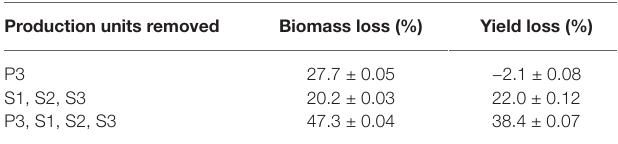
TABLE 2 | Impact of P3 and/or S1–S3 units removal at infiltration on total biomass and H1 yield per plant following heterologous expression. ¥ Production units removed